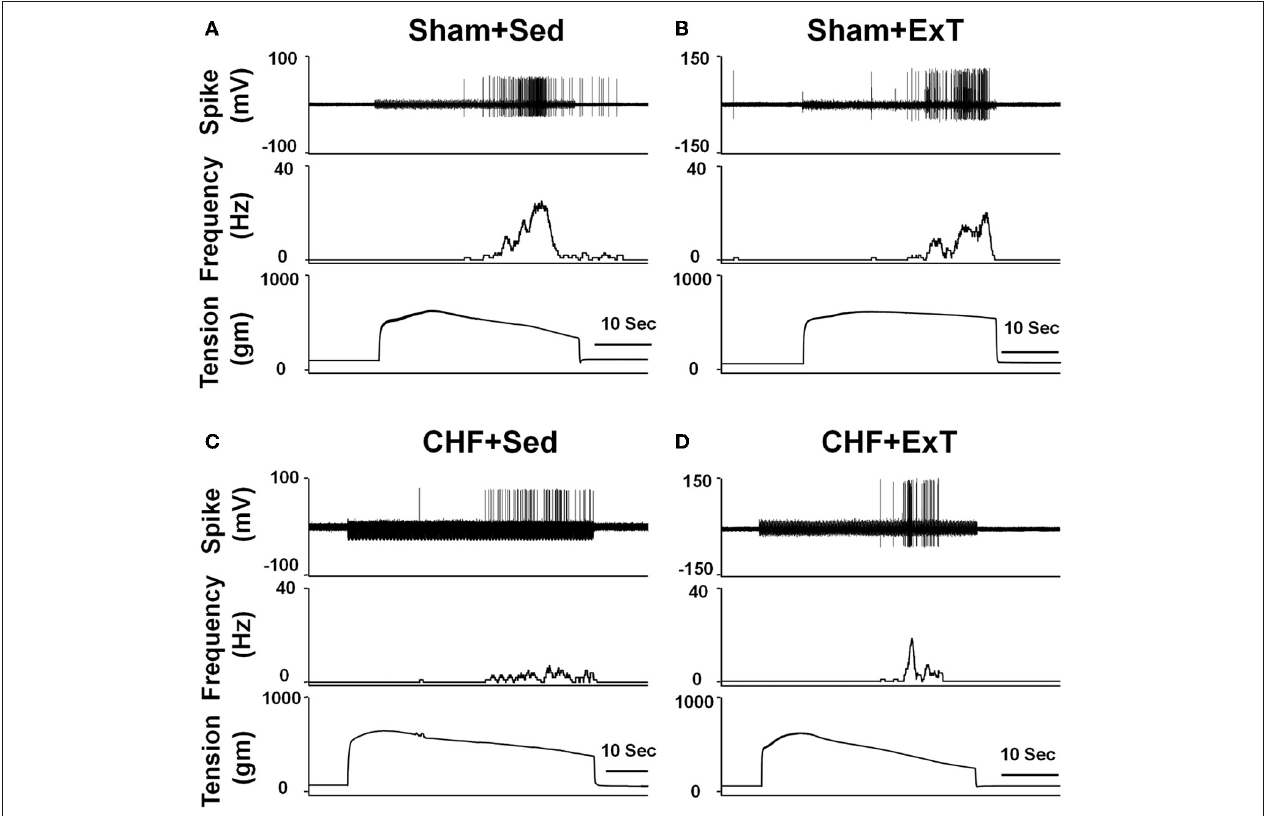
FIGURE 6 | Representative recordings showing the discharge of group IV afferents in response to static contraction induced by electrical stimulation of L5 ventral root in sham + Sed (CV, 1.2m/s, A),